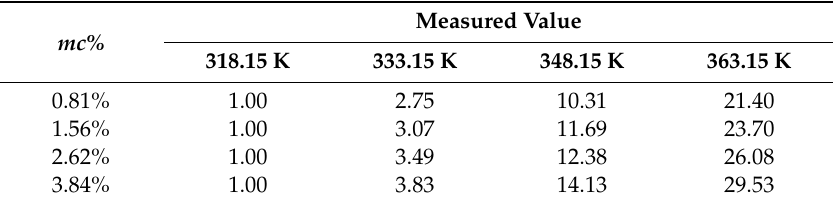
Table 2. Calculation results of the amplitude-shift factors at various